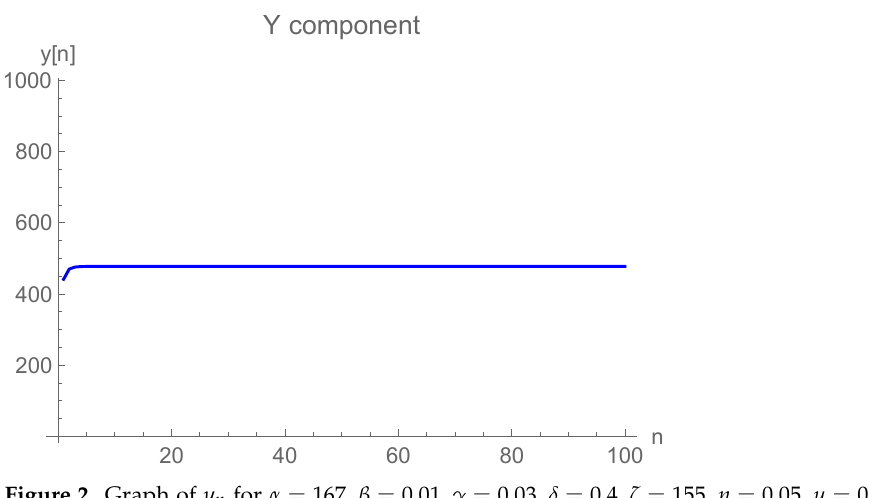
Figure 2. Graph of y n for α = 167, β = 0.01, γ = 0.03, δ = 0.4, ζ = 155, η = 0.05, µ = 0.05, ε = 0.3, υ = 144, ρ = 0.03, σ = 0.08, ω = 0.2. with initial conditions x 0 = 10.0, y 0 = 20.0 and z 0 = 25.0.